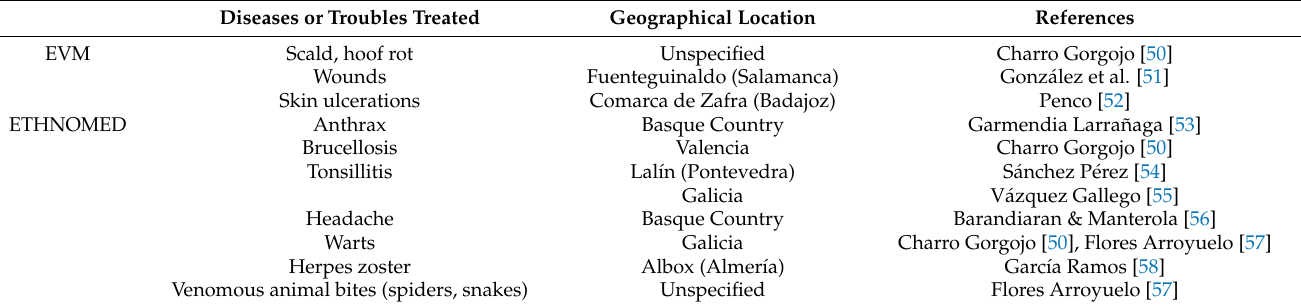
Table 1. Empirical topical remedies based on the use of the natterjack toad in